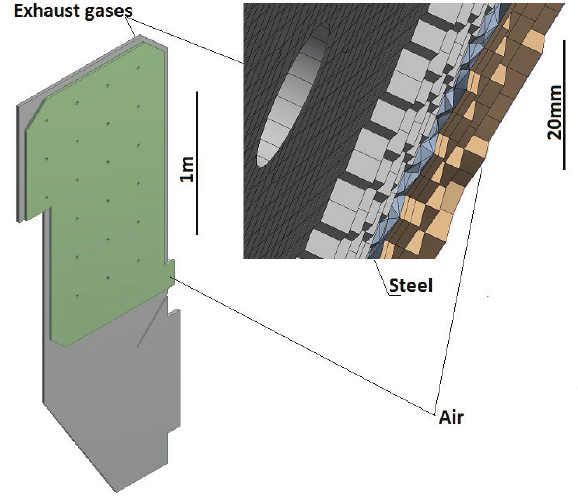
Figure 2: Geometry and mesh of modelled volume.